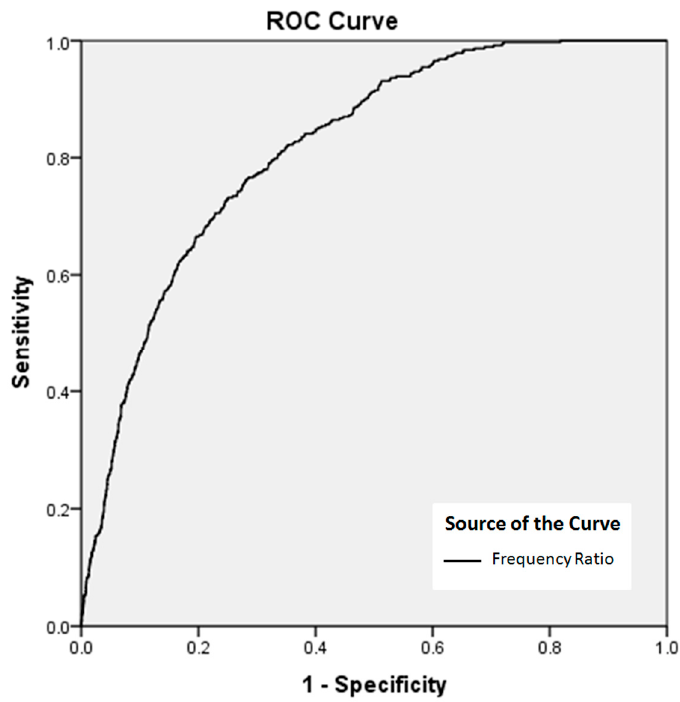
Figure 8. Receiver operating characteristic (ROC) curve of the landslide susceptibility maps created using a traditional algorithm and the area under the curve (AUC) test result variables. The AUC of the frequency ratio method was 0.817.